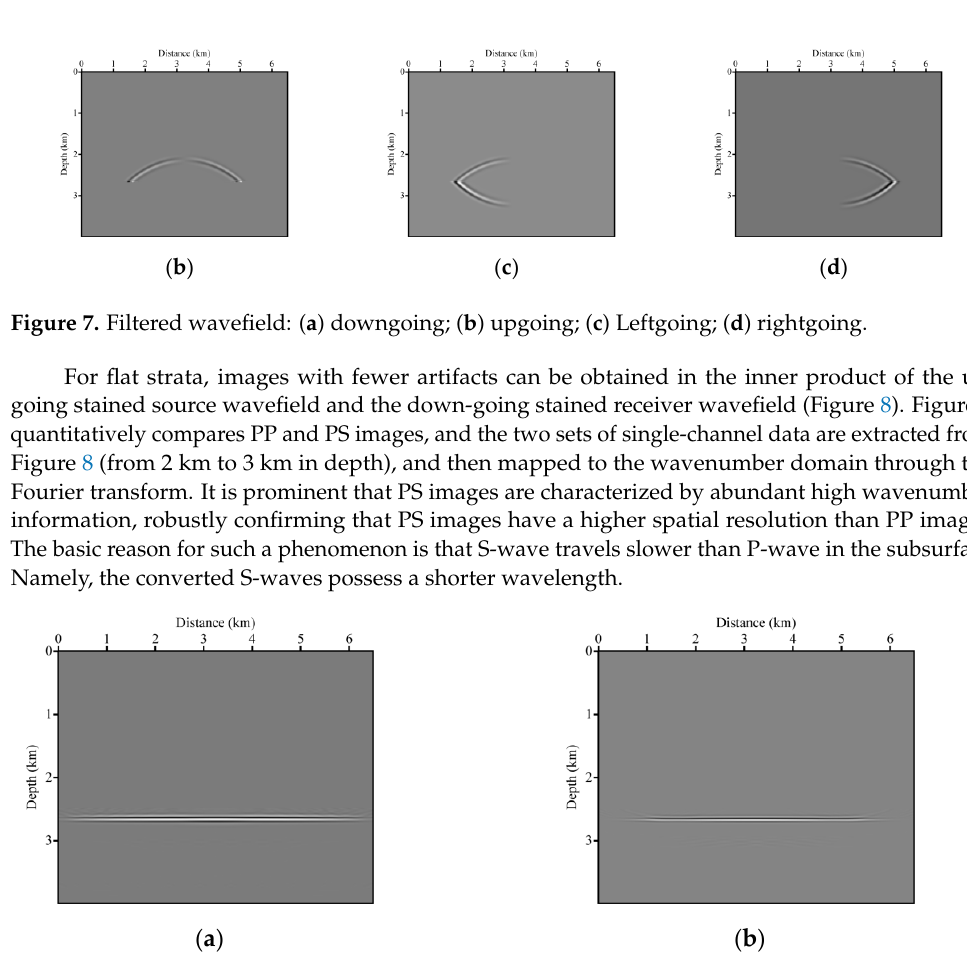
Figure 6. Poynting vector: ( a ) 𝑥 -component; ( b ) 𝑧 -component.